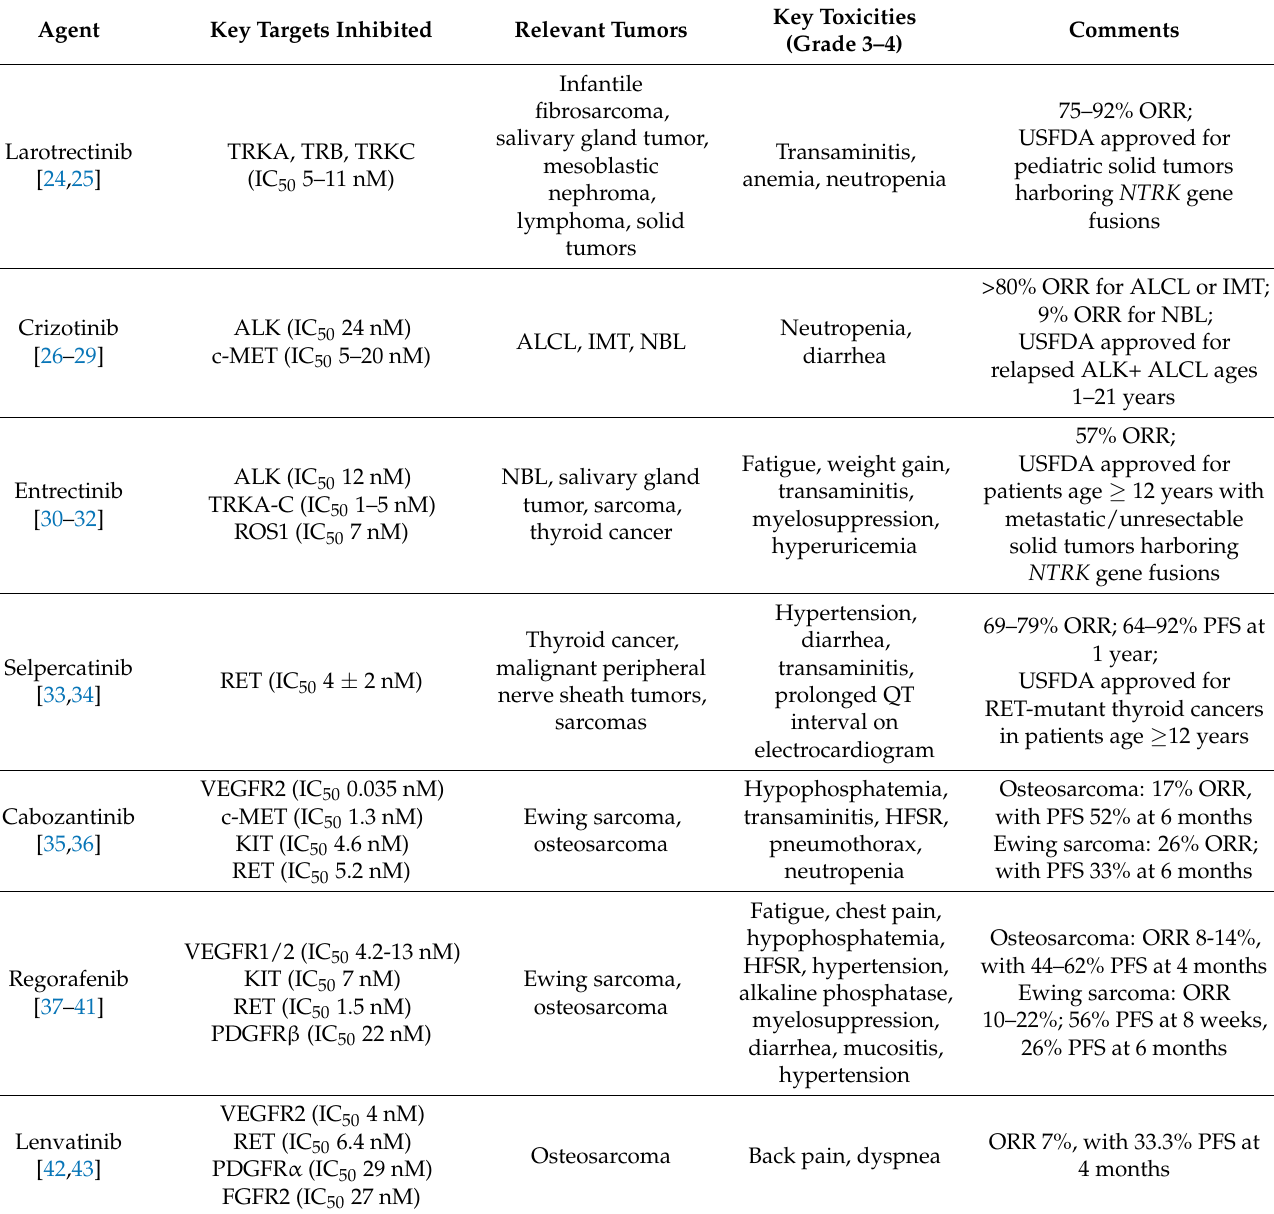
Table 1. Select completed trials of receptor tyrosine kinase inhibitors for pediatric solid tumors †